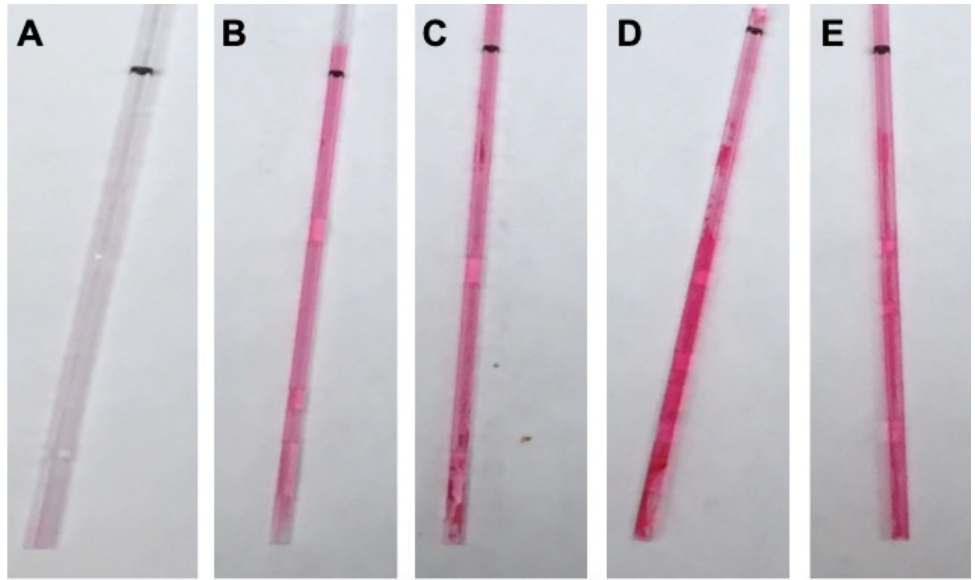
Figure 3. Capillary tubes loaded with R6G with a delay time of 5 min, dried at 3 LPM for ( A ) 0 min,